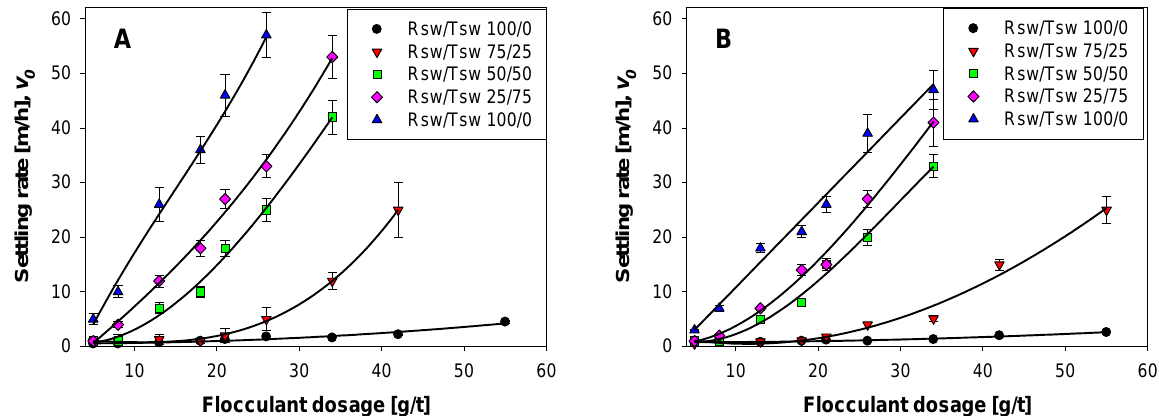
Figure 5. Effect of flocculant dosage on the settling rate of synthetic tailings, using raw seawater (Rsw) and treated seawater (Tsw) at different proportions. ( A ): Tailings 1 with quartz/kaolin at 90/10 ratio; ( B ): Tailings 2 with quartz/kaolin at a 75/25 ratio. Solid concentration: 10 wt%, pH 11.